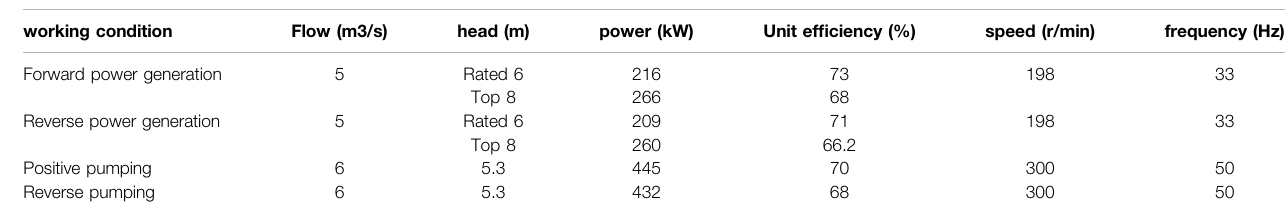
TABLE 1 | Basic parameters of hydraulic